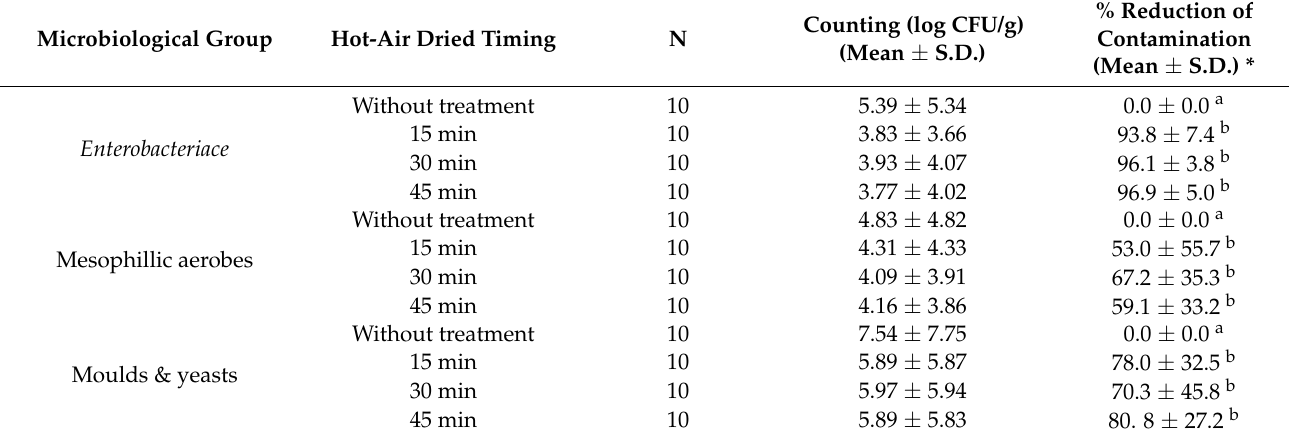
Table 2. Microbial load reduction of hot-air dried pollen (42 ± 1 ◦ C) exposed to three different timing exposure. The results are expressed as number of samples (N), average of CFU counted, and percentage of microbial load reduction (mean ± S.D.).